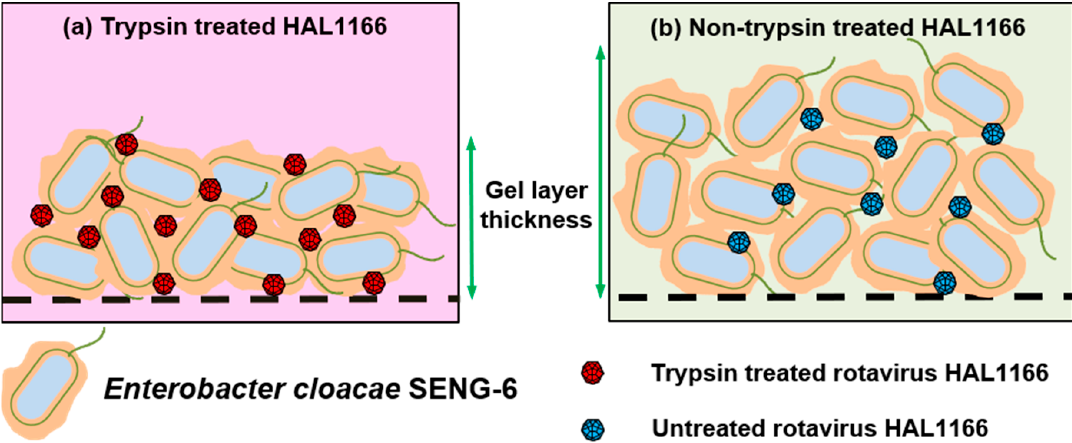
Figure 2. Development of a gel/cake layer on a microfiltration membrane surface during the filtration of a mixture of E. cloacae SENG-6 and rotavirus HAL1166 used as a surrogate for human norovirus. ( a ) The gel/cake layer developed by SENG-6+trypsin-treated rotavirus HAL1166 was less thick; ( b ) The gel/cake layer developed by SENG-6+untreated rotavirus HAL1166 had thicker and larger porosity.